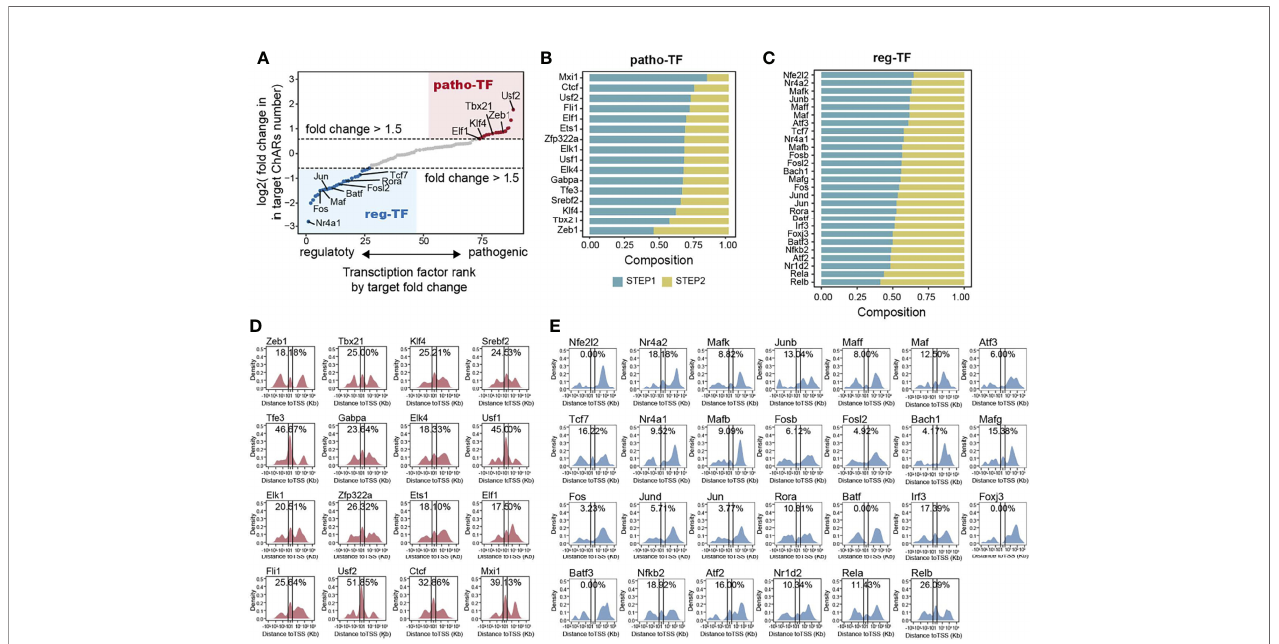
FIGURE 4 | Transcription factor binding motifs enriched from opening- and closing- ChARs exhibit distinct chromatin distribution patterns. (A) Transcription factors (TFs) ranked by the ratio of their binding motifs in patho-ChARs to that in reg-ChARs. Transcription factors with more than 1.5fold change (motifs in patho-ChARs/ motifs in reg-ChARs) were denoted as patho-TFs, while transcription factors with less than 0.67 fold change (motifs in patho-ChARs/motifs in reg-ChARs) were denoted as reg-TFs. (B) Distribution of patho-TFs ranked by the ratio of their binding motifs with increased accessibility in fi rst step of the Th17 to Th1 conversion to those in the second step. (C) Distribution of reg-TFs ranked by the ratio of their binding motifs with decreased accessibility in fi rst step of the Th17 to Th1 conversion to those in the second step. (D) Distance of patho-TFs targeted binding motifs in opening-ChARs to their neighboring TSSs. Percentage of ChARs found within +1 to -1 Kb of TSS were calculated. (E) Distance of reg-TFs targeted binding motifs in closing-ChARs to their neighboring TSSs. Percentage of ChARs found within +1 to -1 Kb of TSS were